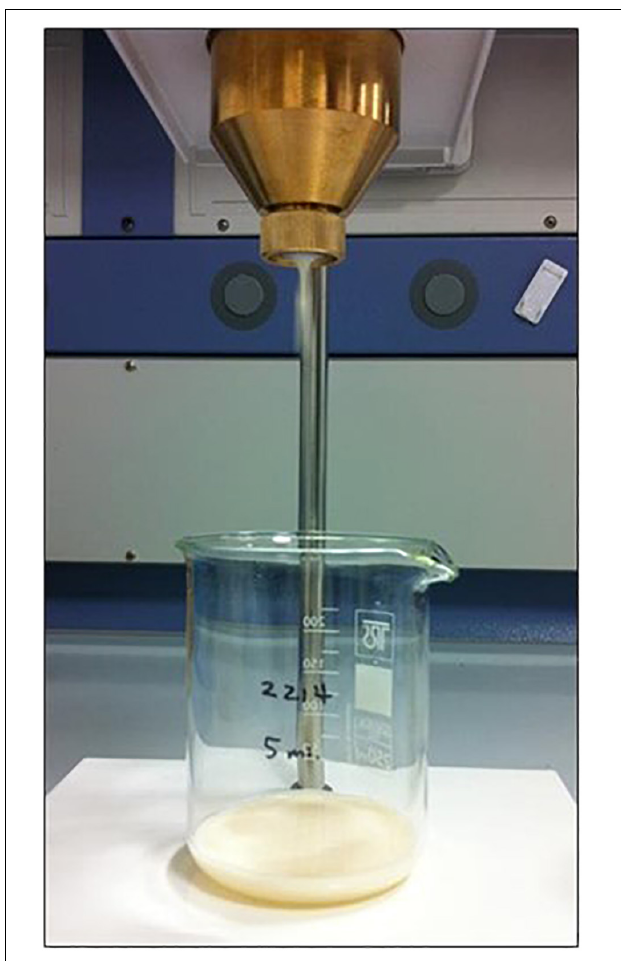
FIGURE 2 | Ford cup used to measure the viscosity of fermented milk by weighing the milk flowing through an orifice of 3 mm